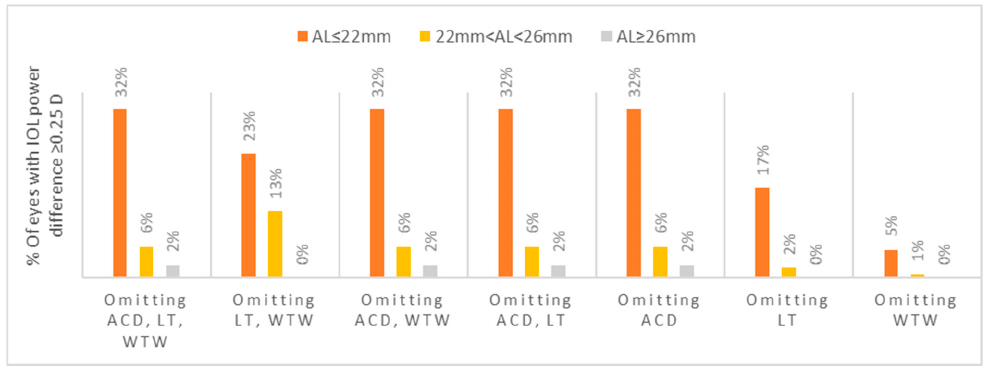
Figure 3. Percentage of eyes with a mean absolute difference of ≥ 0.25 D in the IOL power calculated between selected partial and all biometry data, stratified by axial length. ACD; anterior chamber depth, D; diopters, IOL; intraocular, LT; lens thickness, WTW; white-to-white.